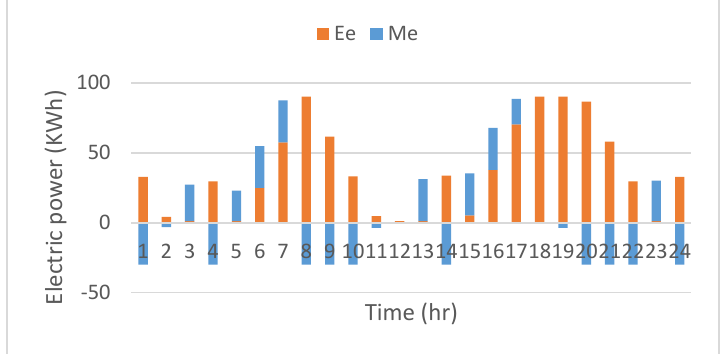
Figure 13. Equivalent storage electricity flows and the state of charge (SOC) of electrical storage in a winter off-day for the last year.